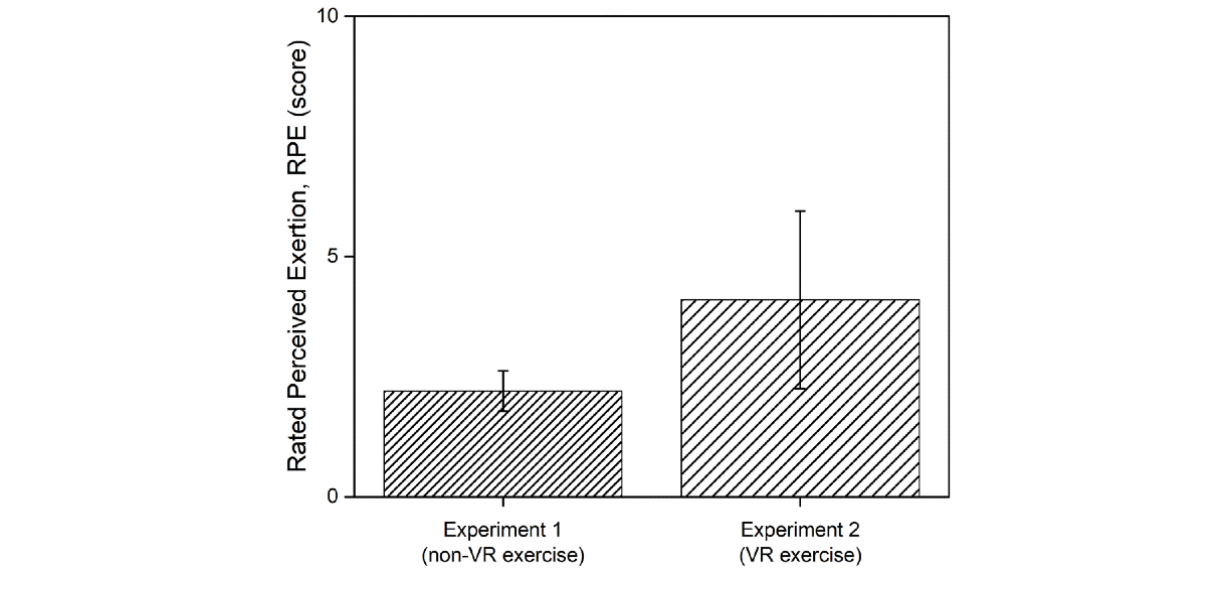
Figure 3. The RPE measured in experiment 1 and experiment 2. VR: virtual reality.